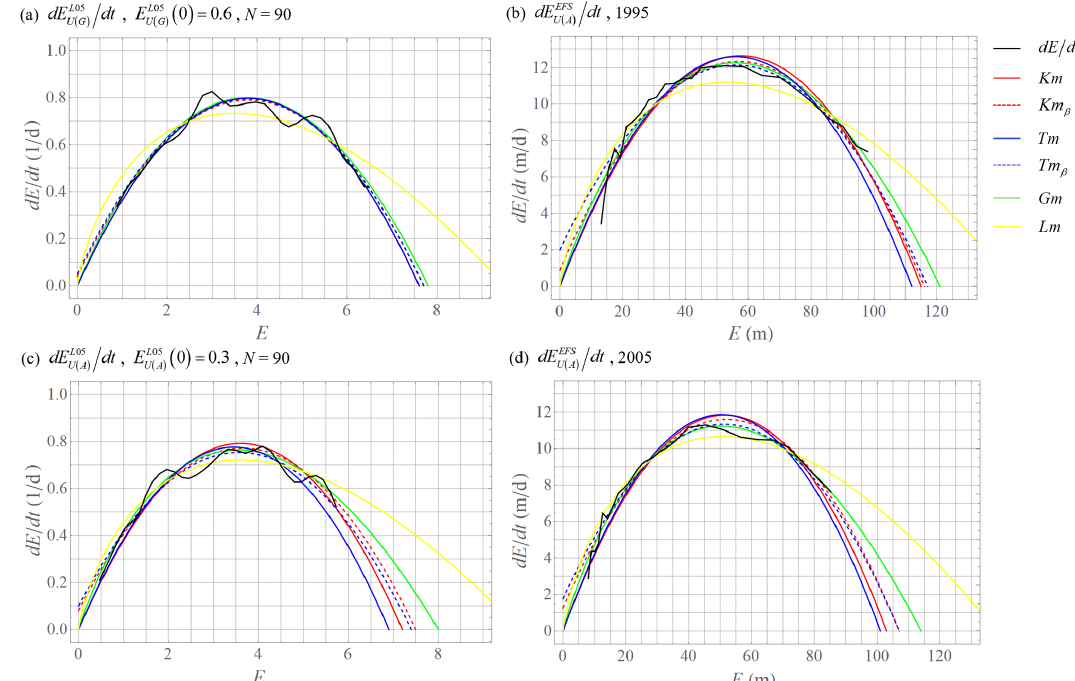
Figure 3. Approximations of differences of upper-bound predictability curves (representative samples). (a, b) The most similar predictability curves in the year 1995 of the ECMWF forecasting system. (c, d) The most similar predictability curves in the year 2005 of the ECMWF forecasting system. Parameters from Tm used in Km (blue) and parameters from Tm β used in Km β (blue